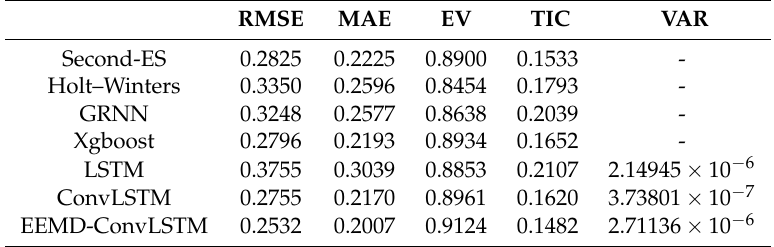
Table 3. The four evaluation metrics of different models. Second-ES, Second Exponential Smoothing; GRNN, General Regression Neural Network; Xgboost, eXtreme gradient